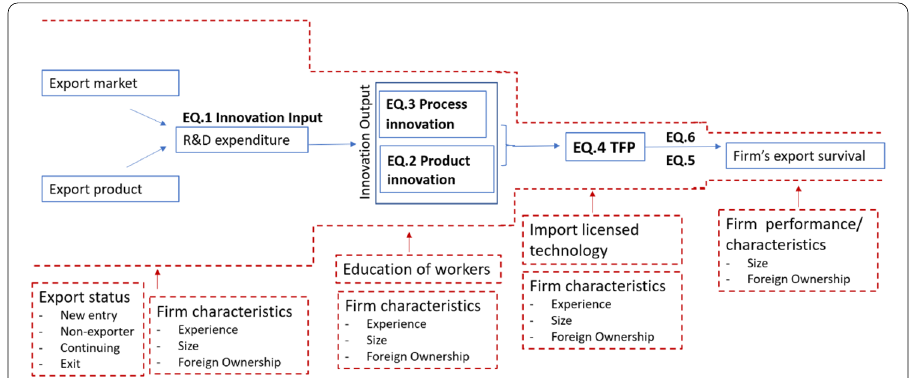
Fig. 1 A framework of the present research (source: